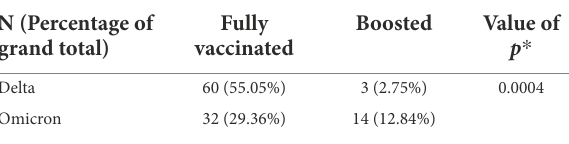
TABLE 8 Contingency table of SARS-CoV-2 variant vs. fully vaccinated/boosted status. N (Percentage of grand